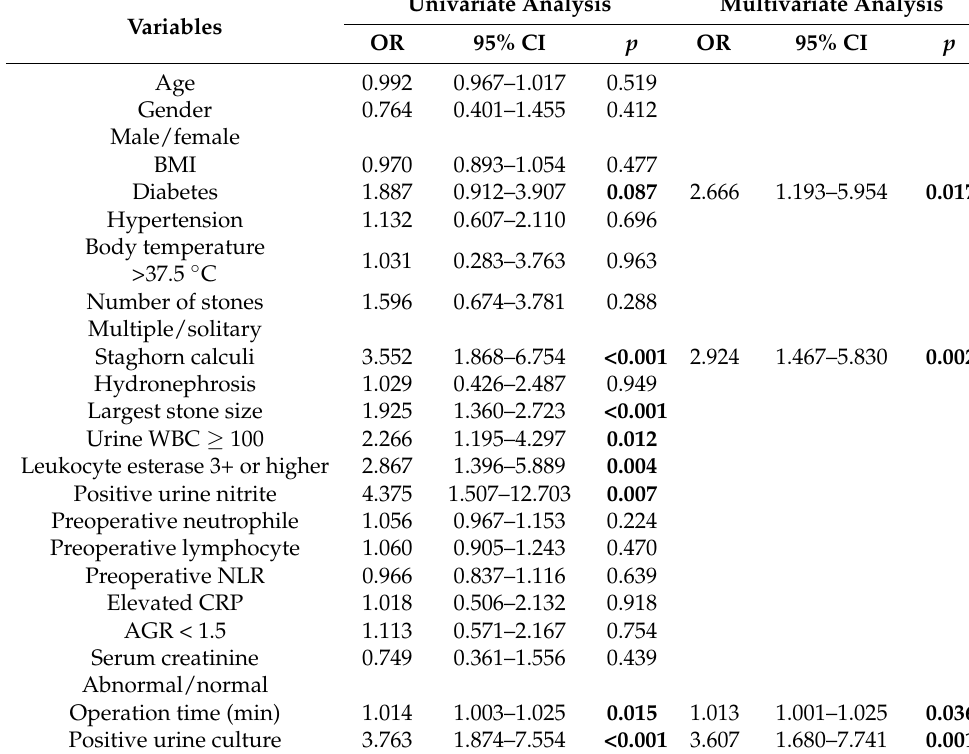
Table 3. Univariate analysis and multivariate binary logistic regression analysis.